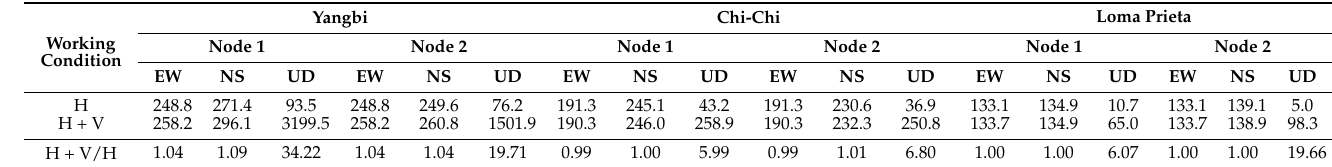
Table 4. Peak acceleration of the top layer in EW, NS, and UD directions/(cm · s − 2